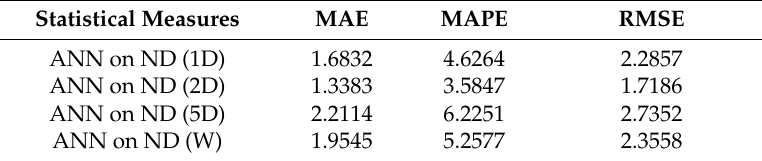
Table 2. Statistical measurements result for ANN prediction on normalized data.